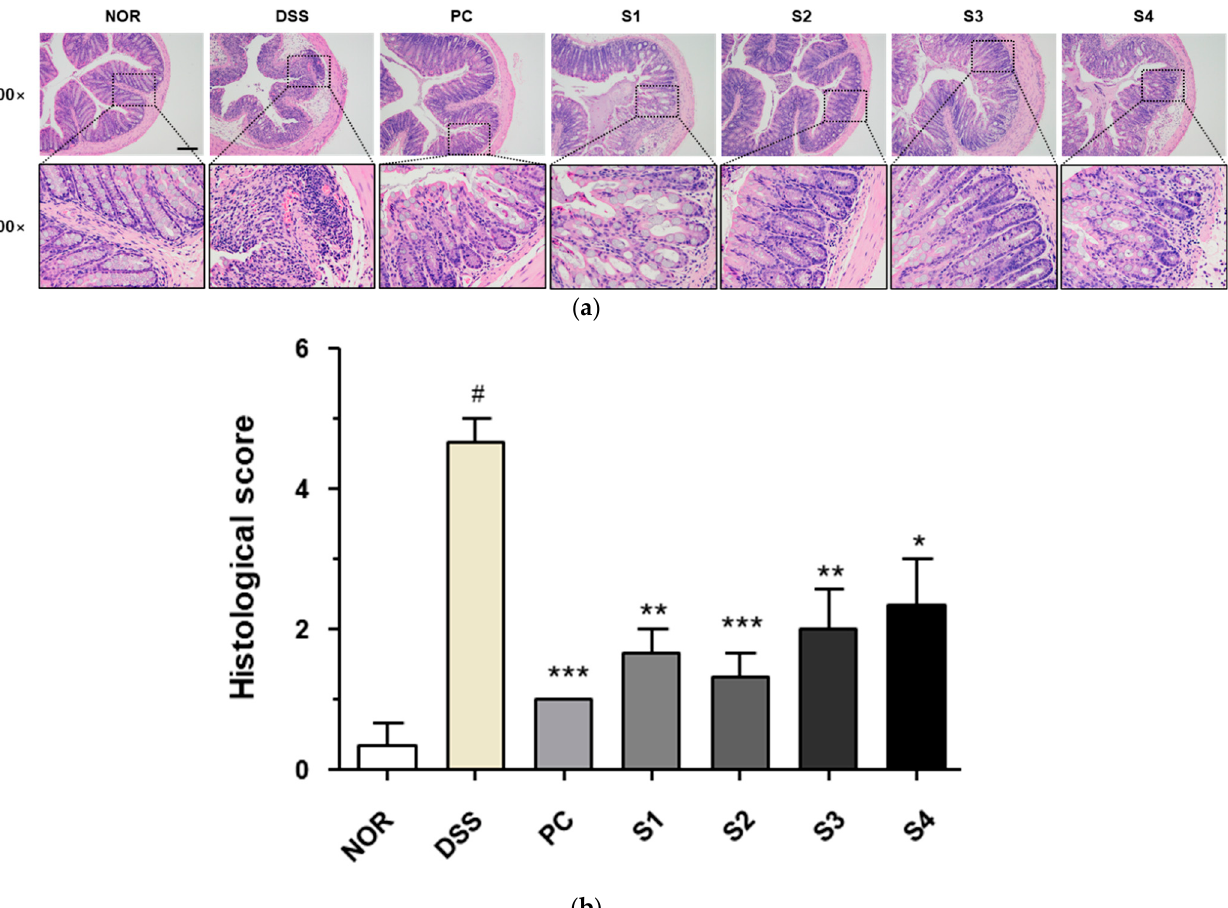
Figure 3. Histological changes in colorectal tissues of DSS-induced colitis mice: ( a ) Representative H&E images of colon tissue. Scale bar; 100 μ m; ( b ) Histological score. Values are presented as the mean ± SD (n = 5); #, p < 0.005 versus normal group; ***, p < 0.001; **, p < 0.005; *, p < 0.05 versus DSS group.